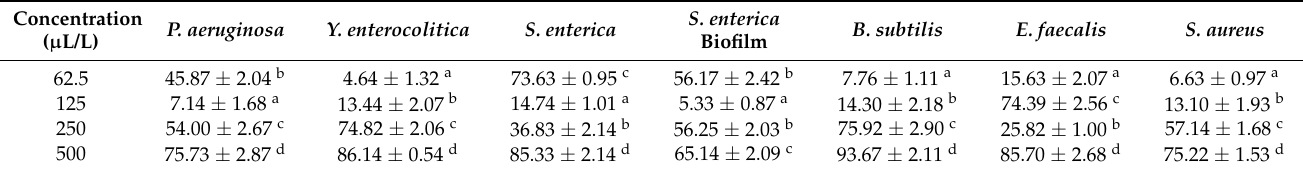
Table 7. Bacterial growth inhibition after FEO addition